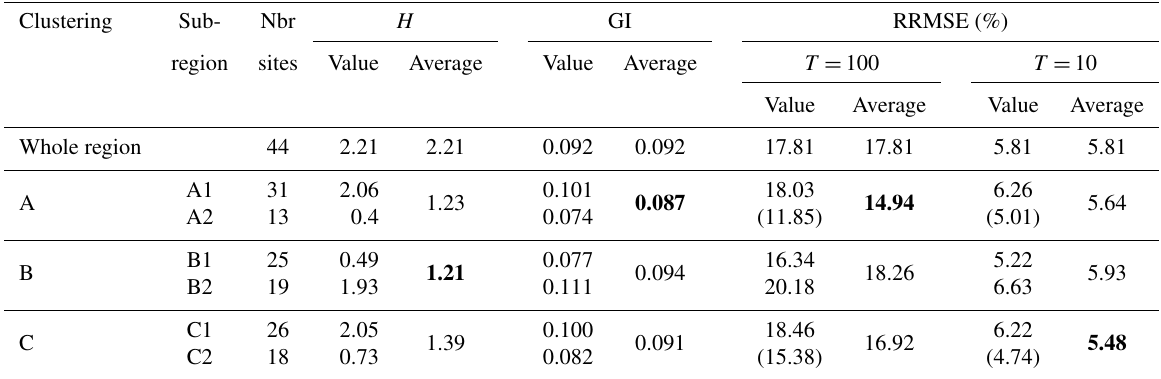
Table 4. Results of the illustrative application: heterogeneity measures H and GI, and RRMSE. RRMSE values are associated with the GLO regional distribution; RRMSE values within parentheses are associated with the GEV regional distribution. Bold values indicate the best result for each